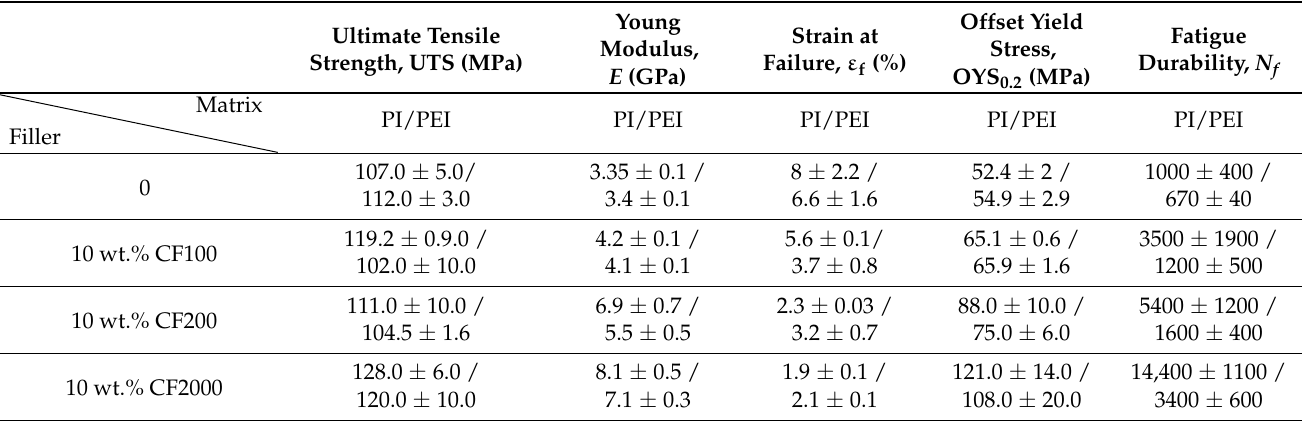
Offset Yield Young Strain at Stress, Failure, ε f (%) OYS 0.2 (MPa)